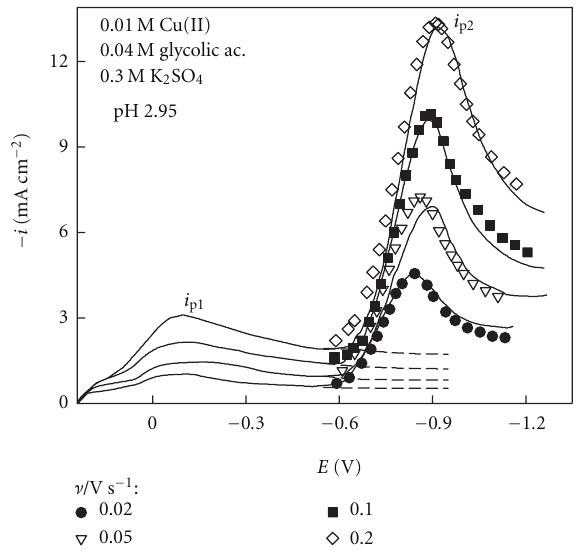
Figure 1: Comparison of voltammetric data obtained at di ff erent potential sweep rates ν for Cu(II)-containing (solid lines) and Cu(II)-free (symbols) solutions. The latter data are superimposed on the limiting currents of Cu(II) reduction (dotted